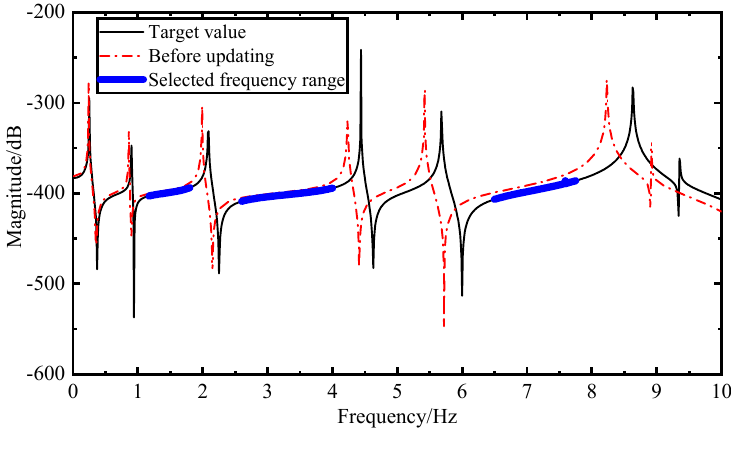
Figure 10. Selected frequency range.